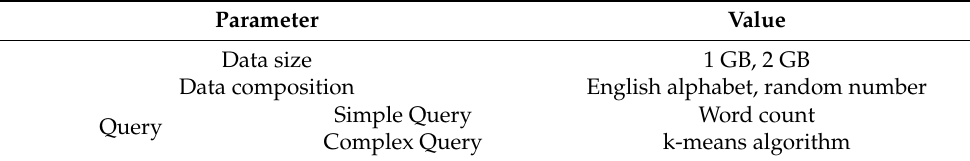
Table 4. Query type of performance